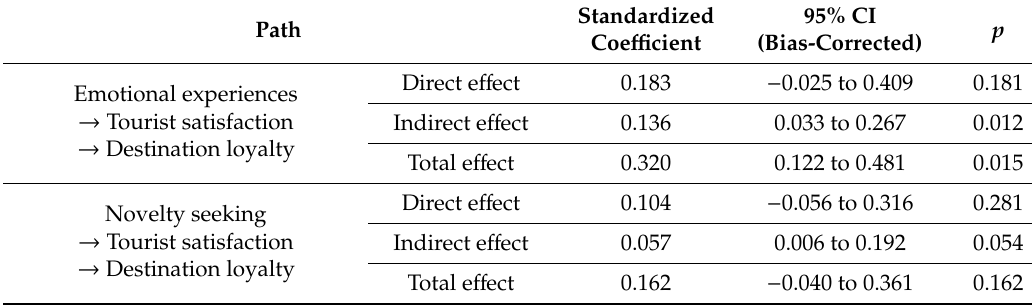
Table 4. E ff ects mediating tourist